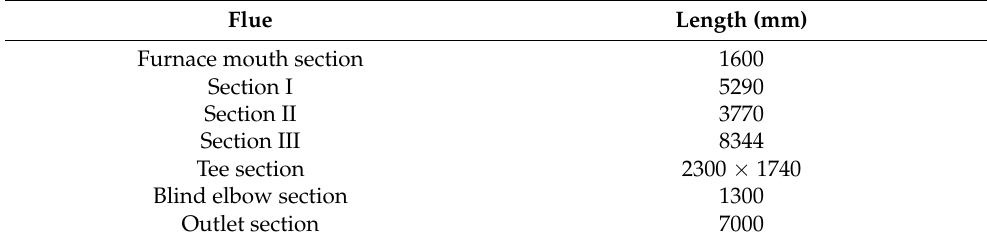
Table 1. The parameters used by the model.